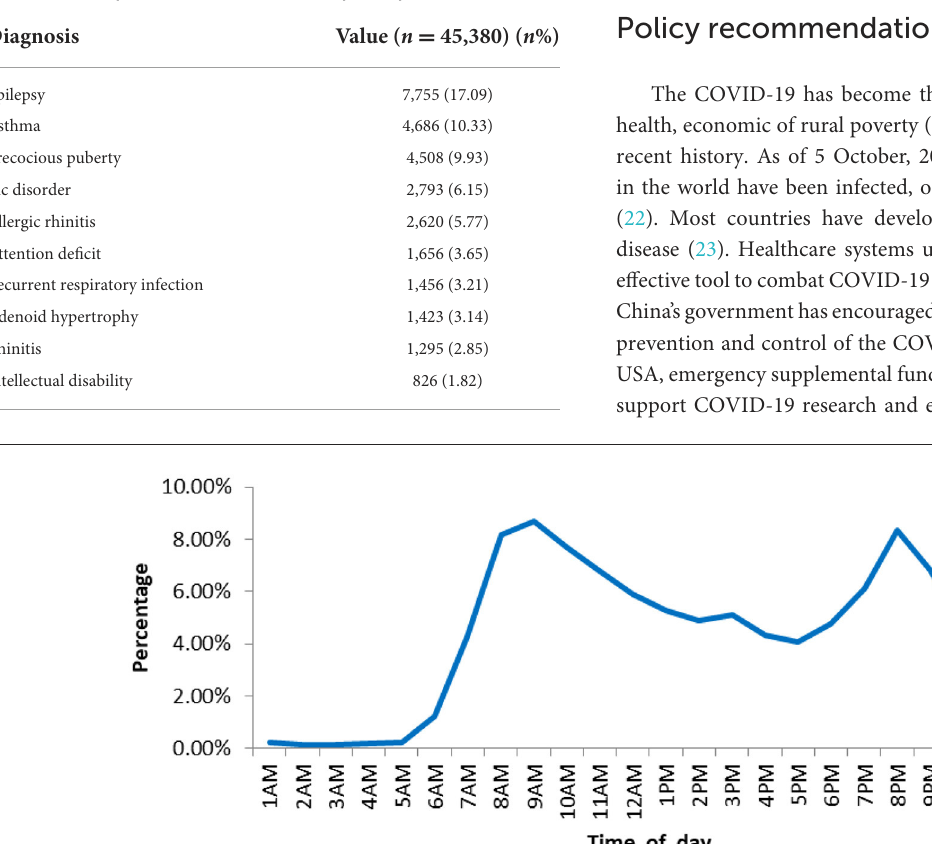
TABLE 2 The top 10 diseases for the online prescriptions.